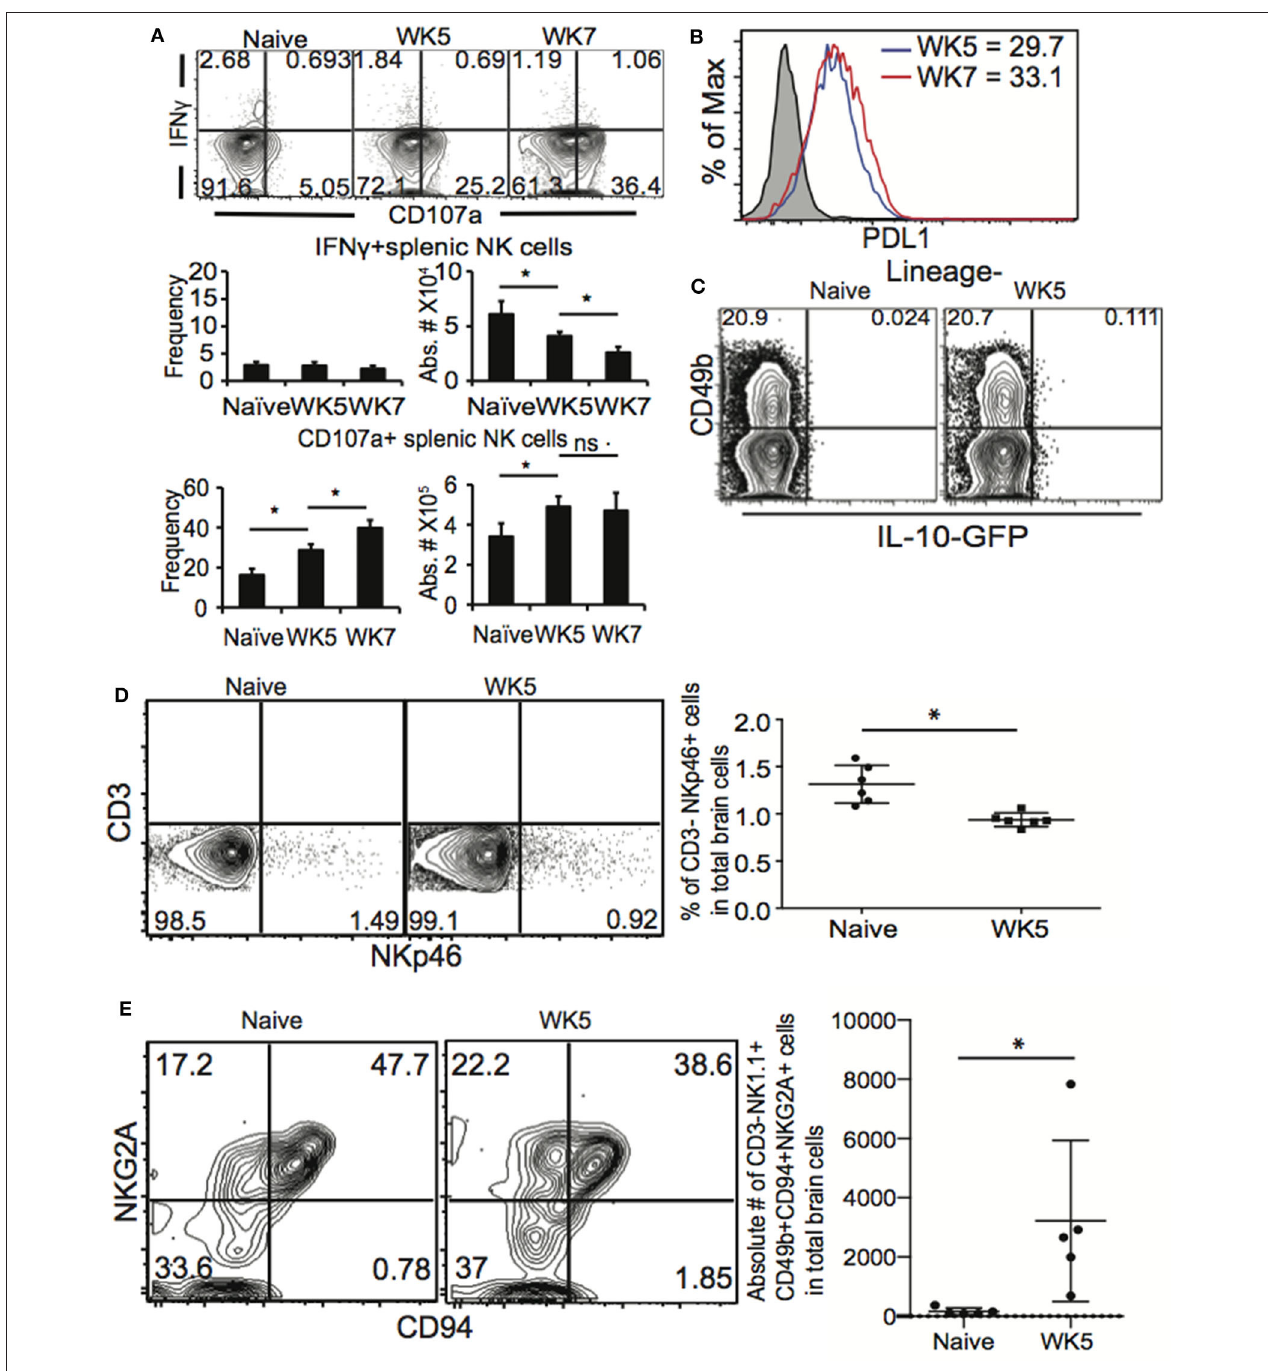
FIGURE 6 | NK cells have altered function during chronic T. gondii infection. C57BL/6 or IL-10 reporter TIGER-GFP mice were orally infected with 10 cysts of ME49 and 5 and/or 7 weeks after infection spleen cells analyzed for function. (A) Spleen cells were stimulated ex vivo with plate bound anti-NK1.1 then stained for NK cells (CD3–CD49b + NKp46 + ) IFN γ and CD107a. Contour plots present frequency data gated on NK cells and compares IFN γ × CD107a. Graphs present the frequency and absolute number of IFN γ + NK cells (top graphs) and CD107a + NK cells (bottom graphs). Graphs present mean ± SD. (B) Splenic NK cells were assayed for PDL1 expression. Histogram presents the MFI of PD-L1 on NK cells from weeks 5 and 7 post infection mice. (C) Contour plots present the frequency of IL-10 GFP + NK cells in naïve compared to week 5 post infection mice. (D) Brain cells were isolated and stained for lineage markers, CD49b and NKp46. Contour plots present the frequency of CD3–NKp46 + cells in the CNS. Graphs present the pooled data from 2 experiments of frequency of CD3–NKp46 + cells in the CNS with n = 3 mice per group. (E) Brain cells form naïve and WK5 infected mice were stained for CD3–CD49b + NK1.1 + CD94 + NKG2A + cells. Contour plots present representative data from 1 experiment repeated 2 times with n = 5 mice per group showing CD3–CD49b + NK1.1 + cells analyzed for the frequency of CD94 and NKG2A + cells. The graph presents absolute numbers of CD94 + NKG2A + cells in total NK cells from brains. Significance is denoted by *with a p ≤ 0.05.